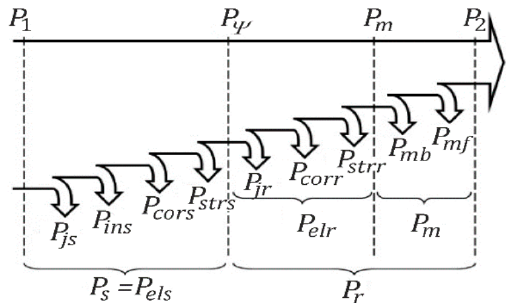
Figure 1. Distribution of power loss components: P 1 —input power, P 2 —output power, P s —stator